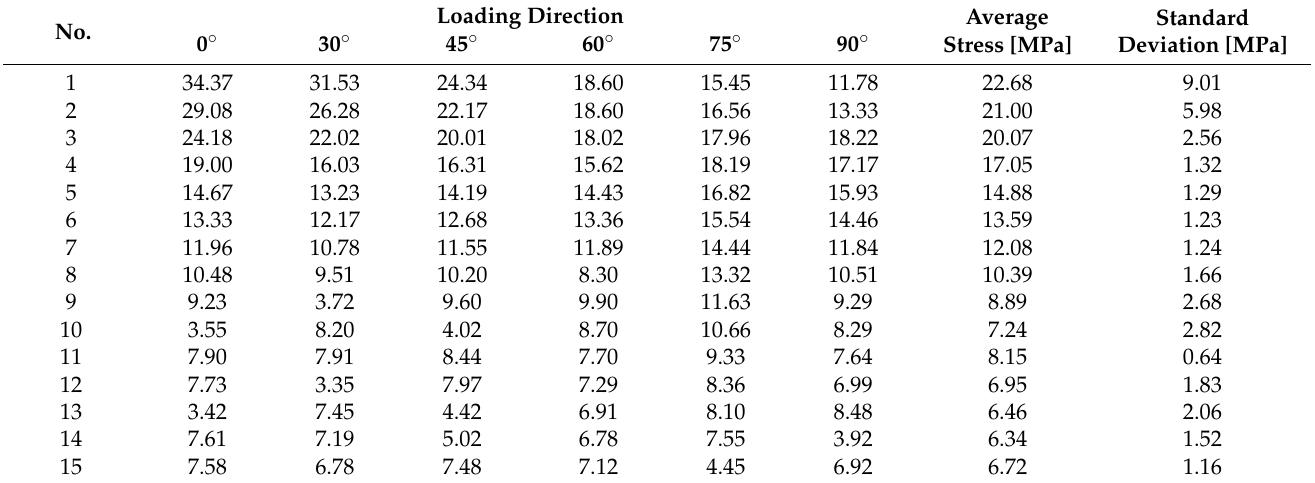
Table 4. Stress values in restorative ceramic.